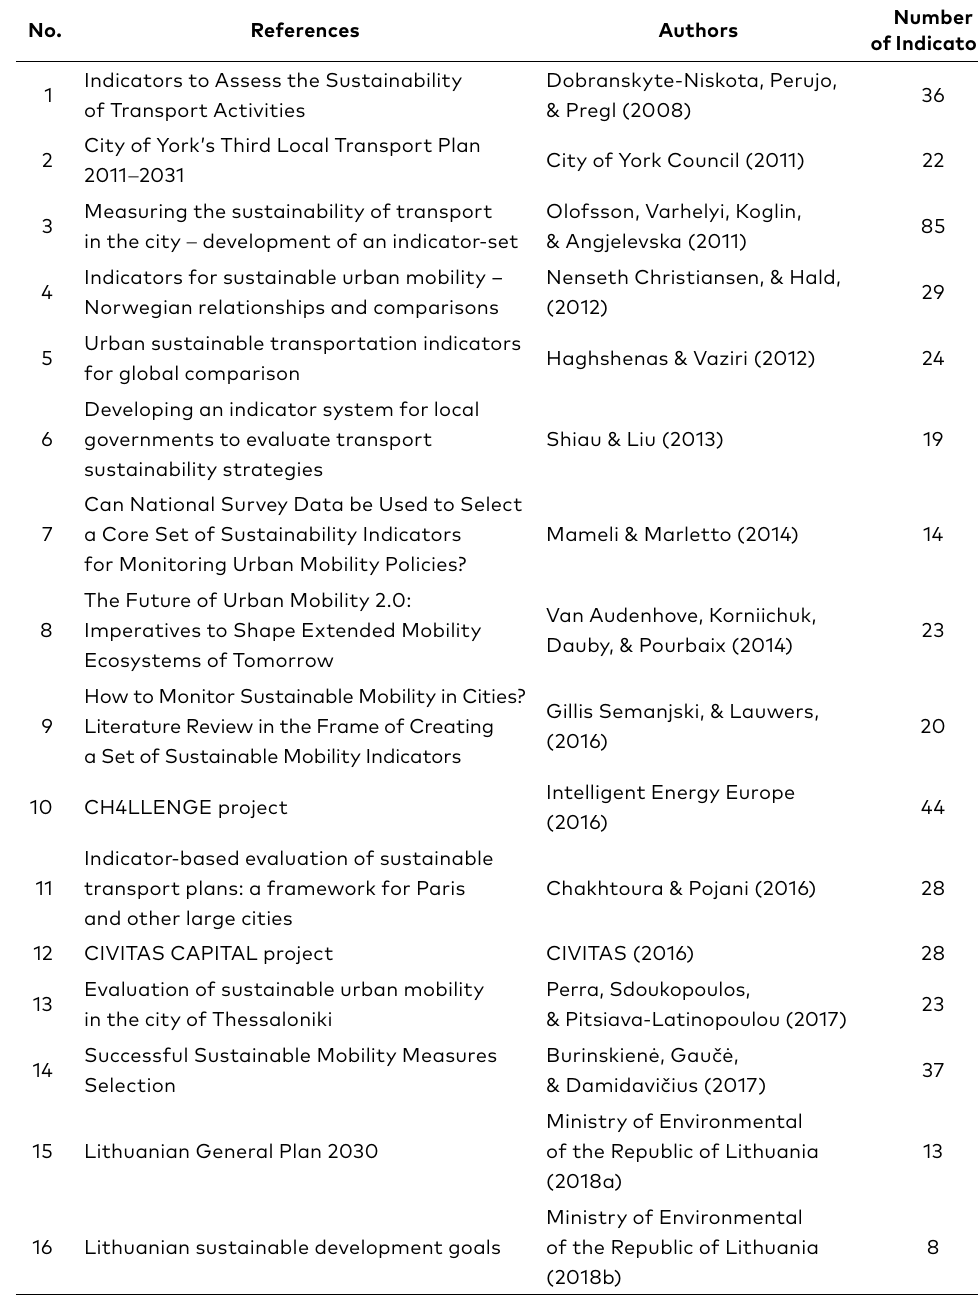
Table 2. Information related to 16